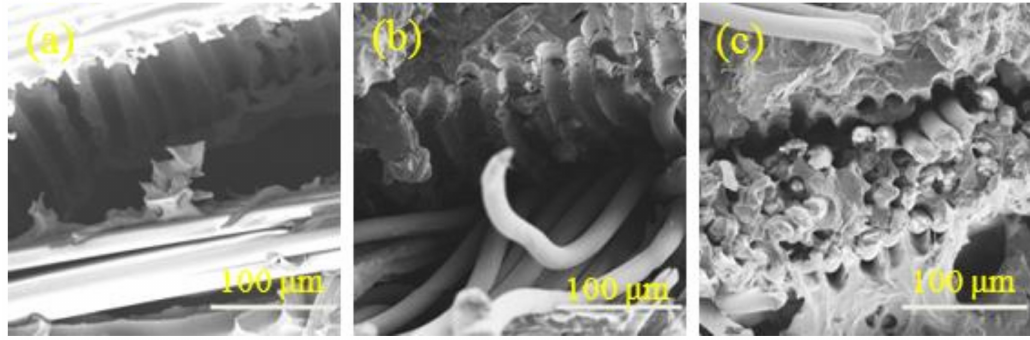
Figure 12. Cross section of ( a ) PF fabric/PVC, ( b ) PF-1 fabric/PVC, and ( c ) PF-2 fabric/PVC